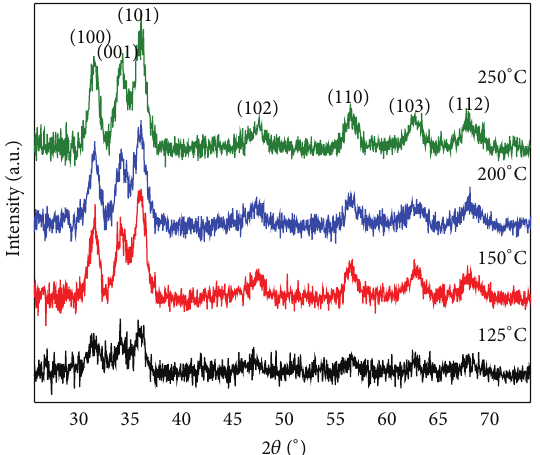
Figure 2: X-ray diffraction patterns of ZnO films grown on ITO glass at different